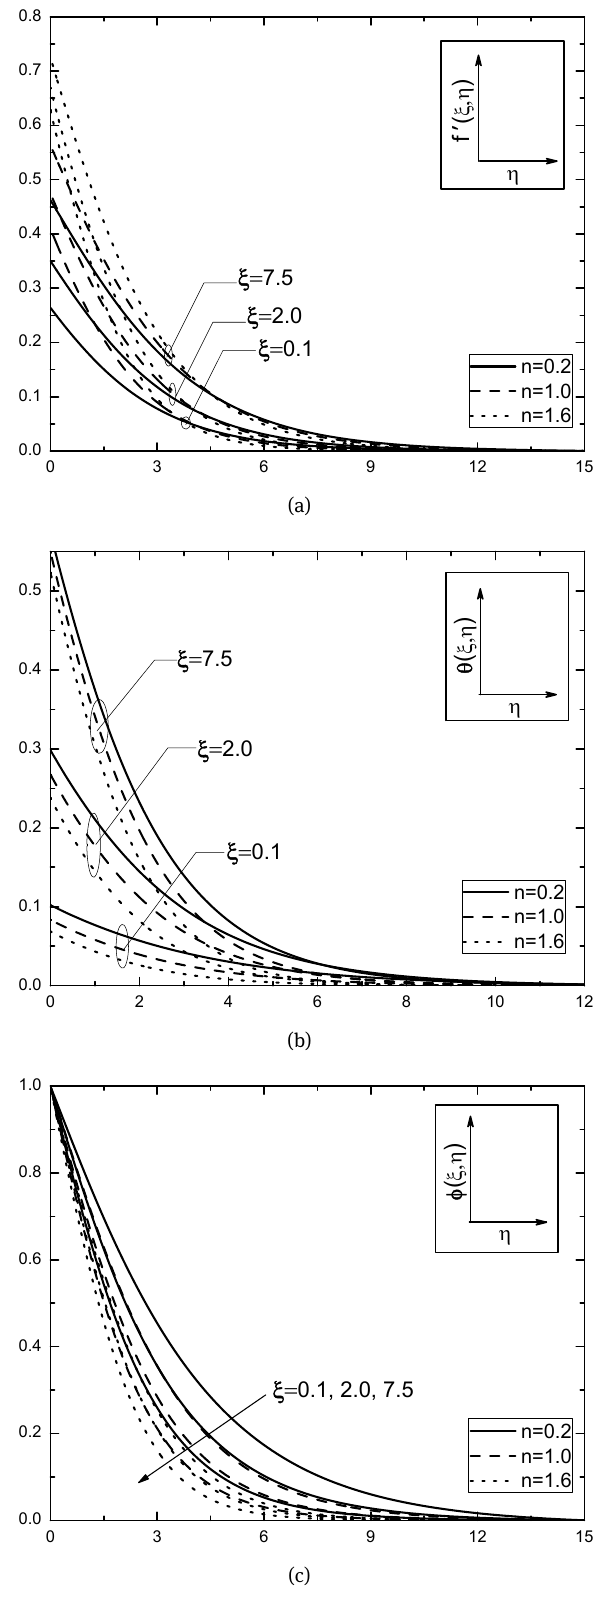
Fig. 2: Effect of ξ for different values of n on the (a) f ′ ( ξ , η ) , (b) θ ( ξ , η ) , and (c) ϕ ( ξ , η ) with the fixed values of α 1 = 1 , α 2 = 1 , Bi = 0.2 , Ω = 30 0